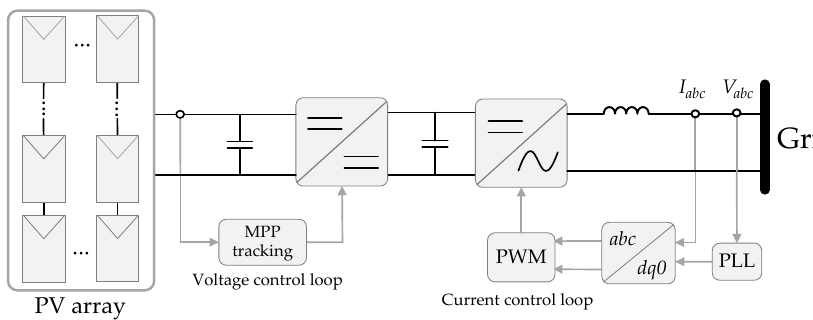
Figure 1. Current and voltage control loops in grid-tie voltage source inverter.